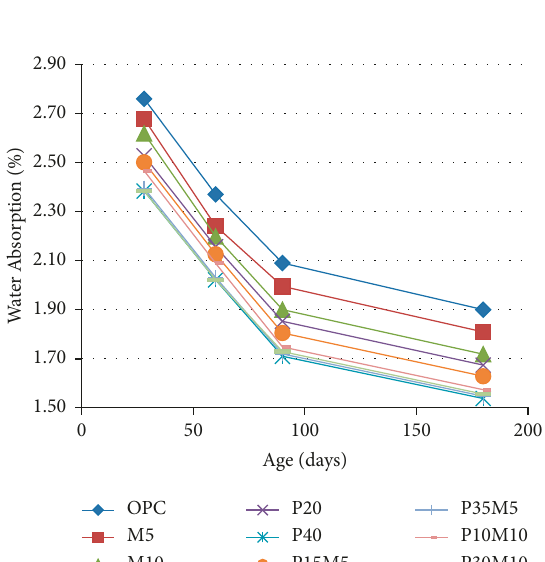
Figure 9: Water absorption of concrete.